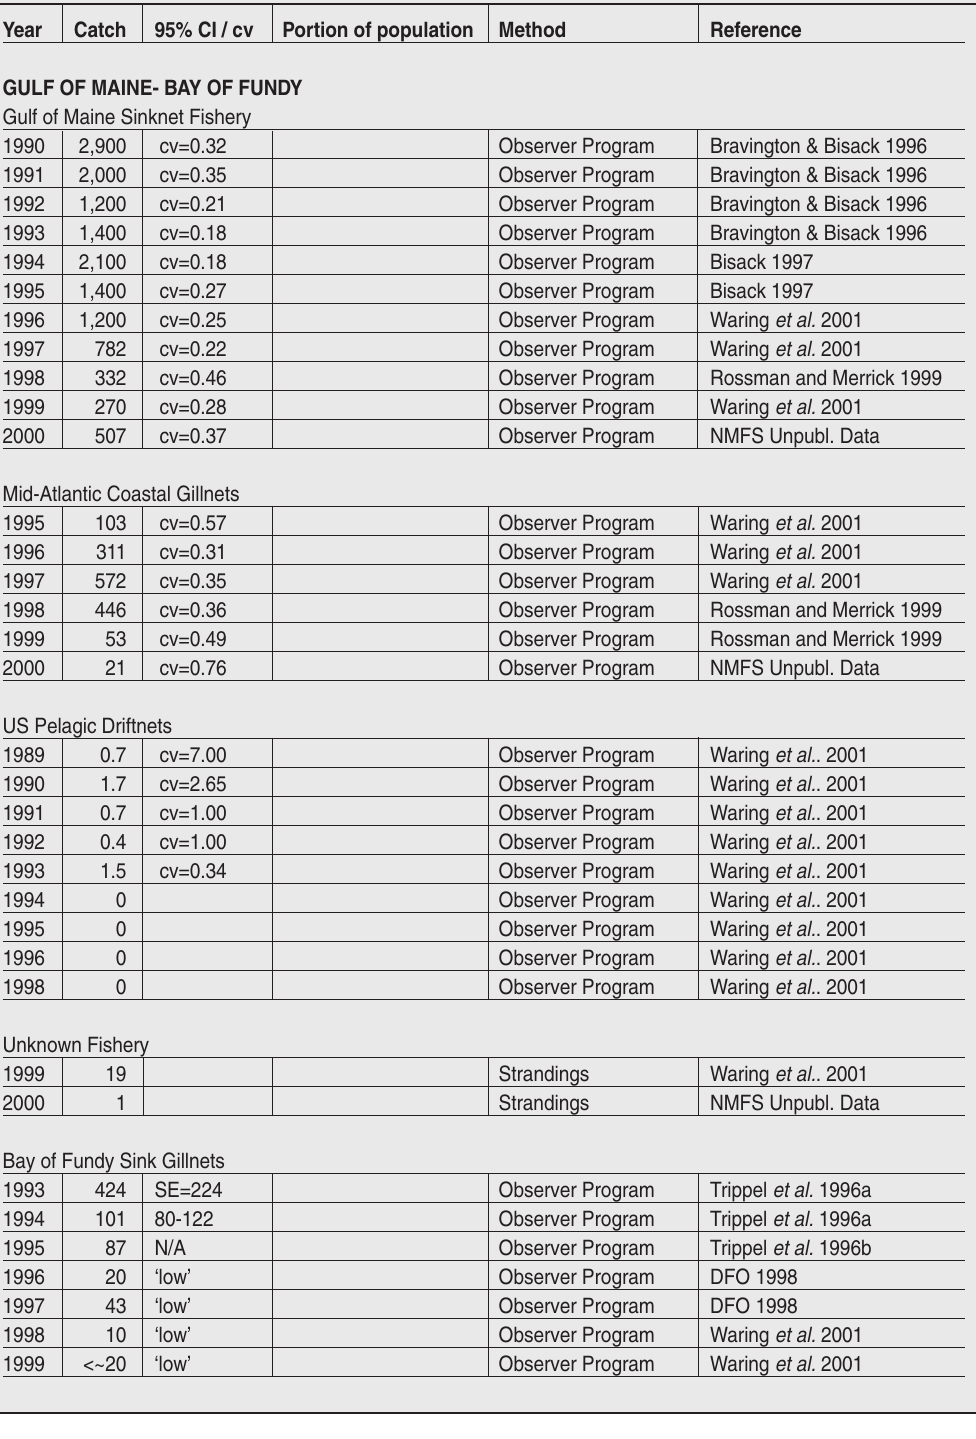
Table 2 . Estimates of harbour porpoise catches in the North Atlantic. Directed catches are shown in bold. Numbers obtained using methods other than observer programs and catch statistics indicate the actual numbers and are not extrapolated to the full fishery unless indi-